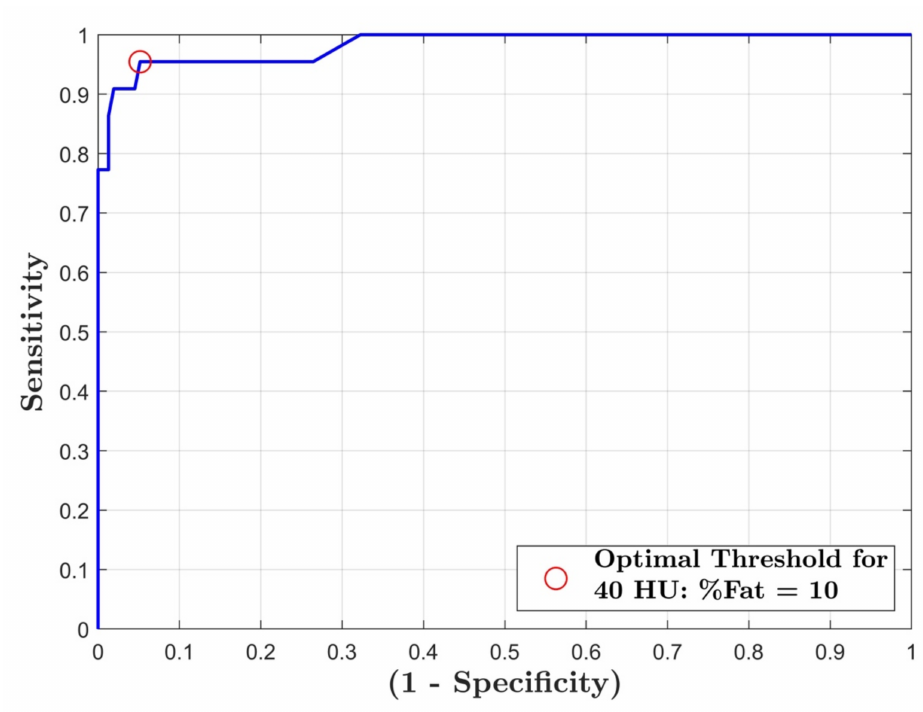
Figure 6. ROC curve for fat percentage threshold with a HU cut-off of 40 HU. Area under the curve (AUC) =